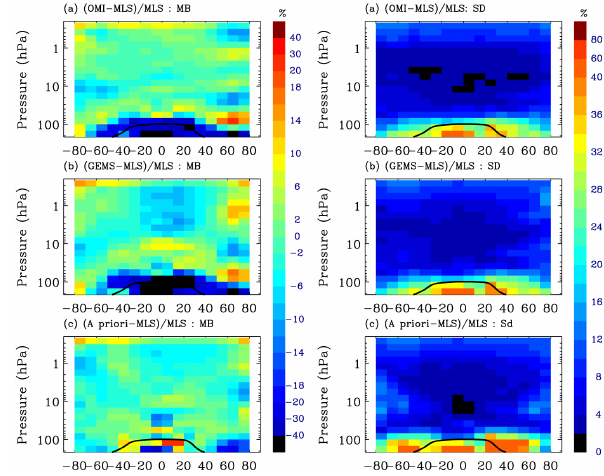
Fig. 7. Same as Fig. 3, but for the use of ML climatology (2012) as a priori